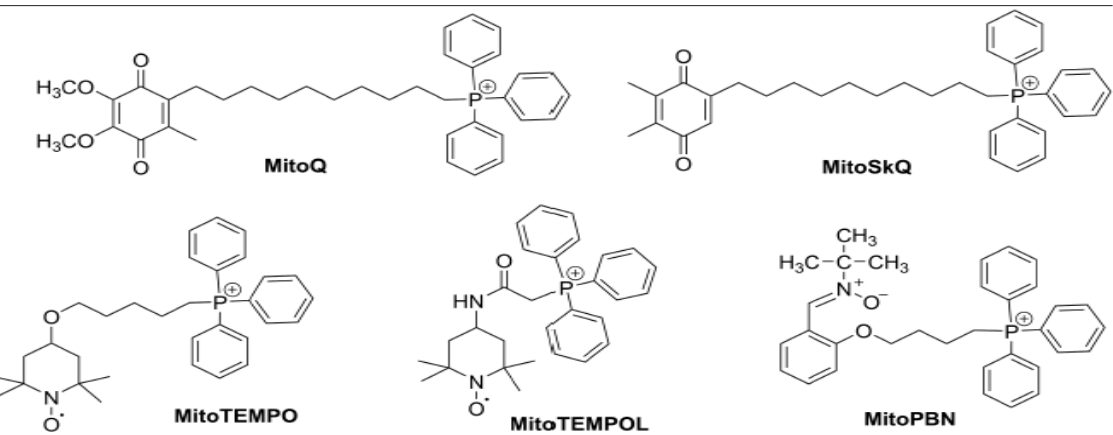
Figure 3. Chemical structures of TPP-linked mitochondrial-targeted antioxidants MitoQ, SkQ1, Mito-TEMO, MITO-TEMPOL and Mito-PBN.